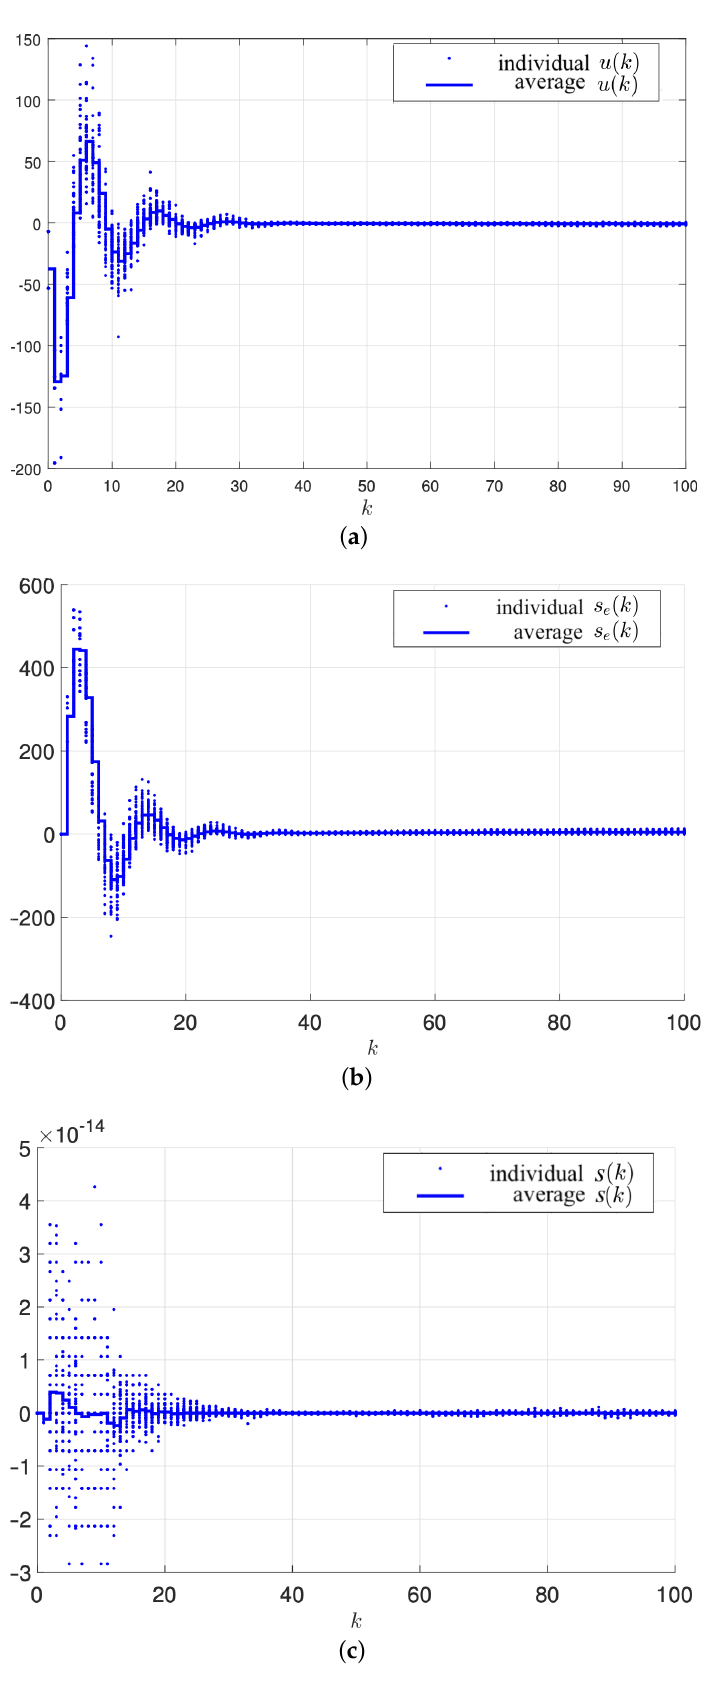
Figure 7. Input trajectories ( a ), trajectory of s e ( k ) ( b ), and trajectory of s ( k ) ( c